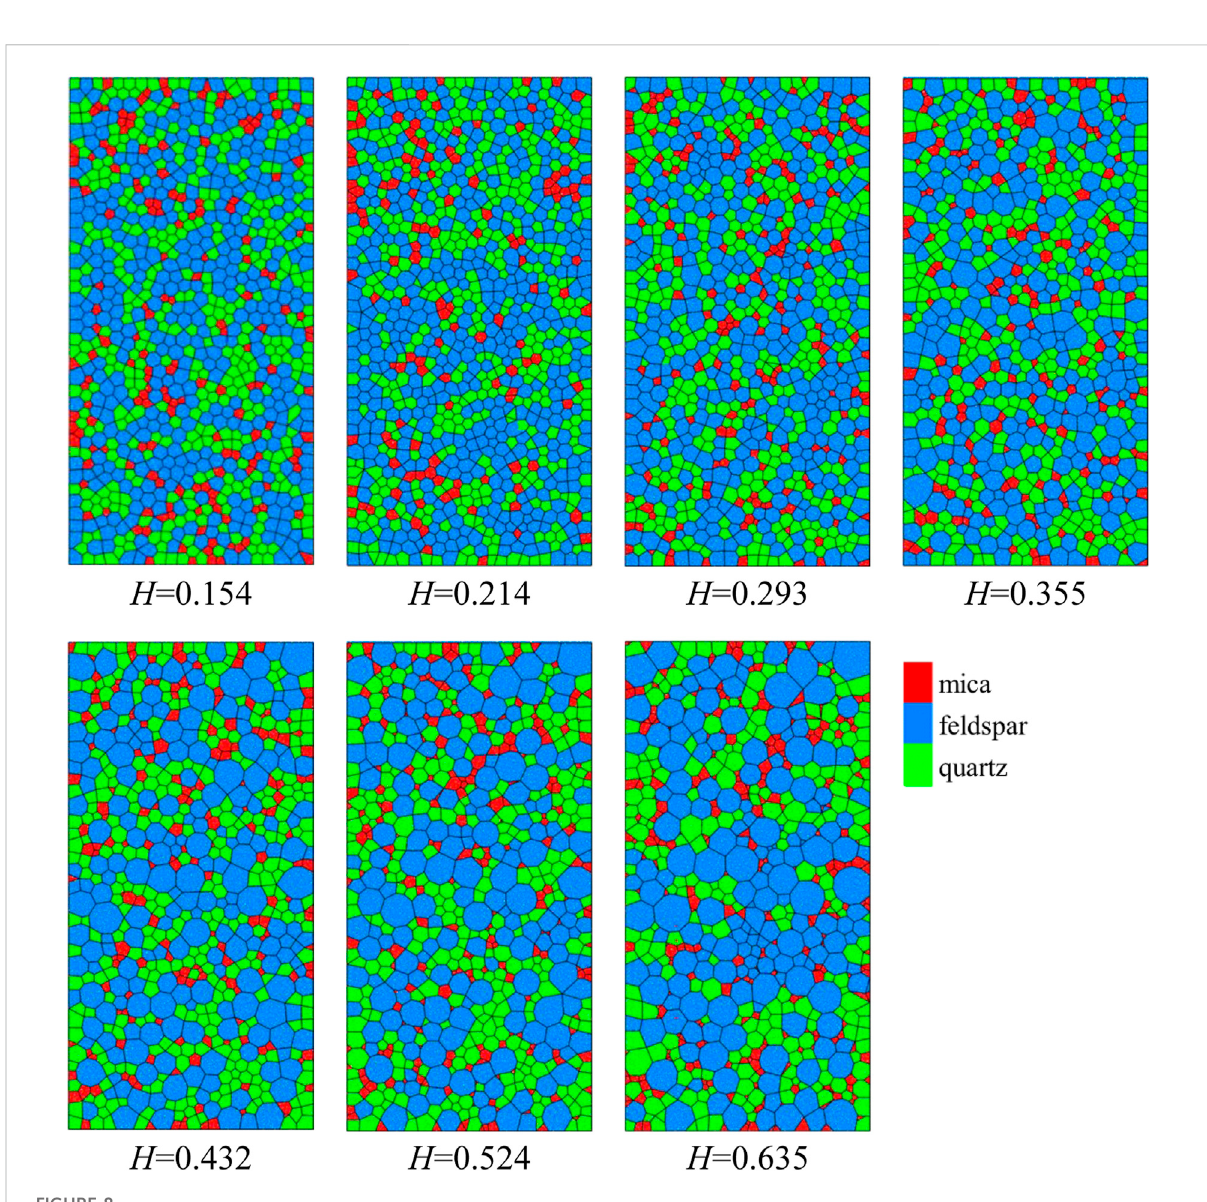
FIGURE 8 Characterization of different inhomogeneity coef fi cient